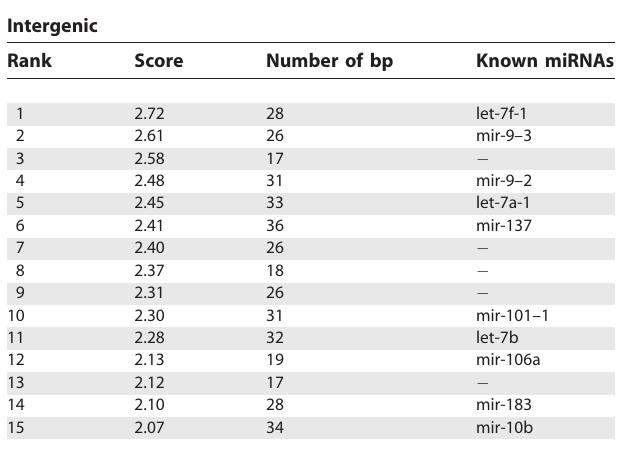
Table 2. Top-Scoring Long-Intergenic Hairpins